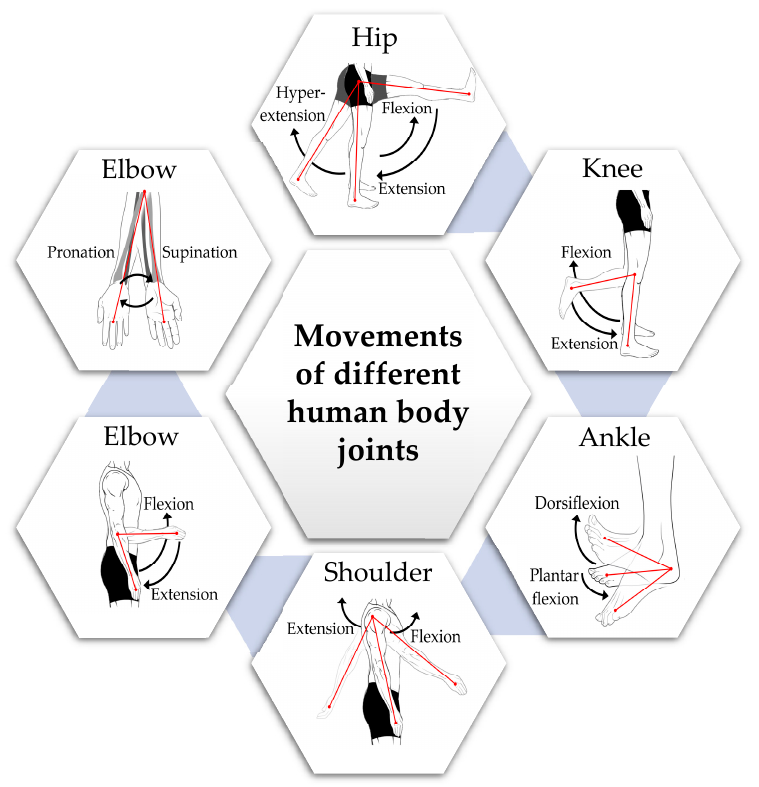
Figure 4. Di ff erent types of human body joints’ Figure 4. Different types of human body joints’ movements.